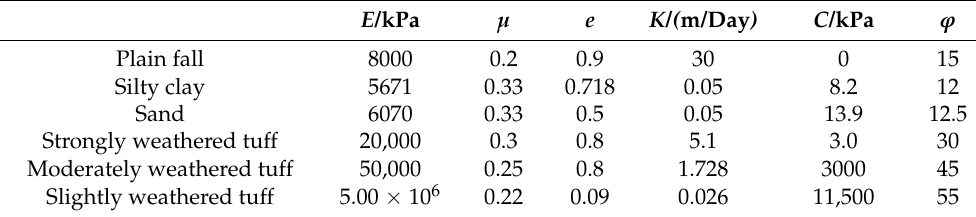
Figure 2. Geological profile of Jing-sha section. Table 1. The parameters of different ground obtained from the geological report.